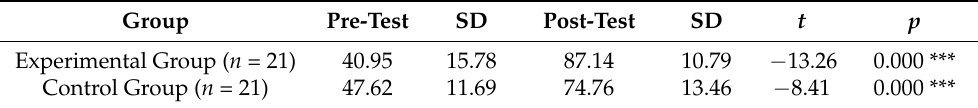
Table 5. Descriptive statistics of learning achievements and results of paired-sample t -test. Group Pre-Test SD Post-Test SD t p Experimental Group ( n = 21) 40.95